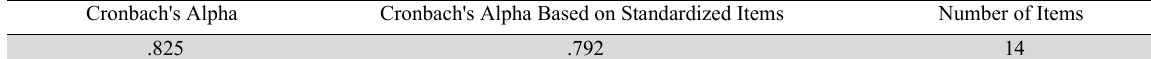
Reliability Statistics